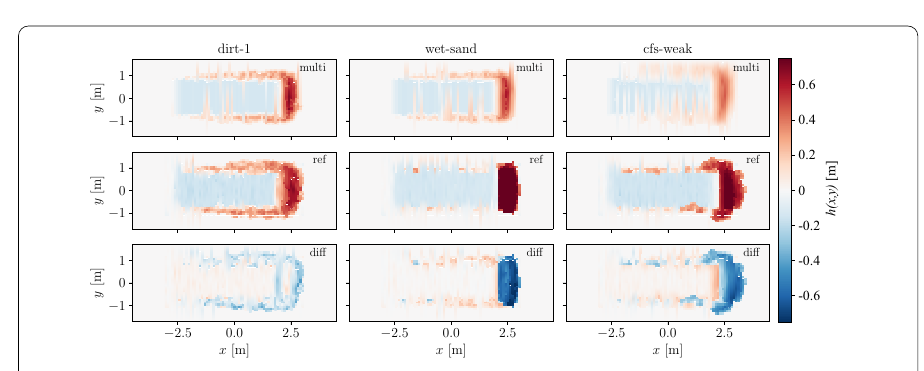
Fig. 13 The resulting surfaces from bulldozing in three cohesive soils using the multiscale model (top row) and the microscale reference model (middle row). The difference is shown at the bottom row